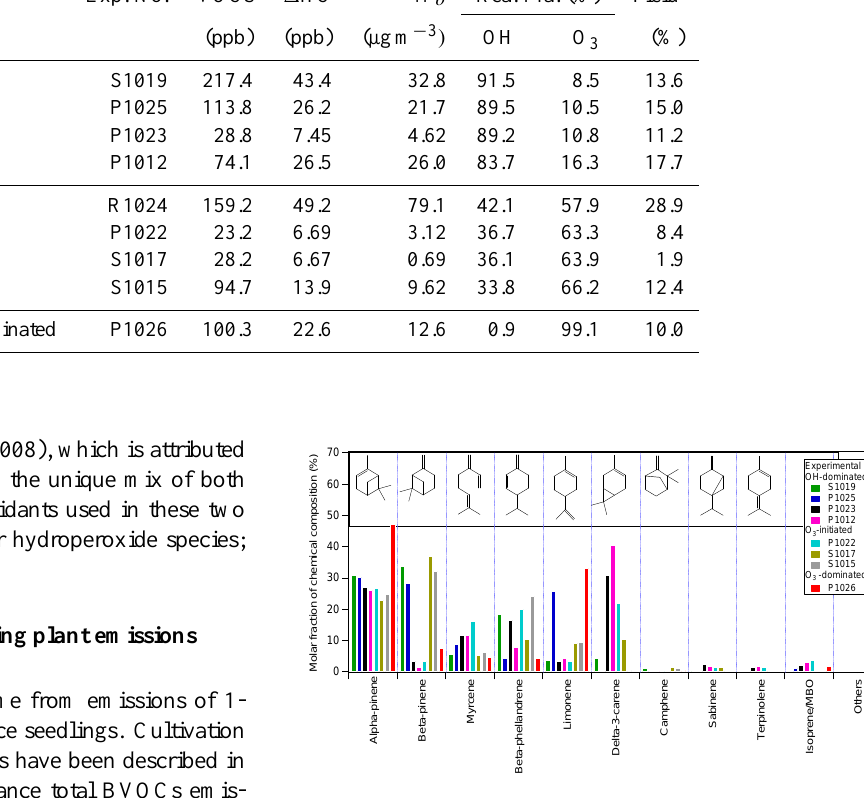
Fig. 3. Percentage molar contributions of detected individual BVOC from plant emissions in different experiments and corresponding BVOC molecular structures.